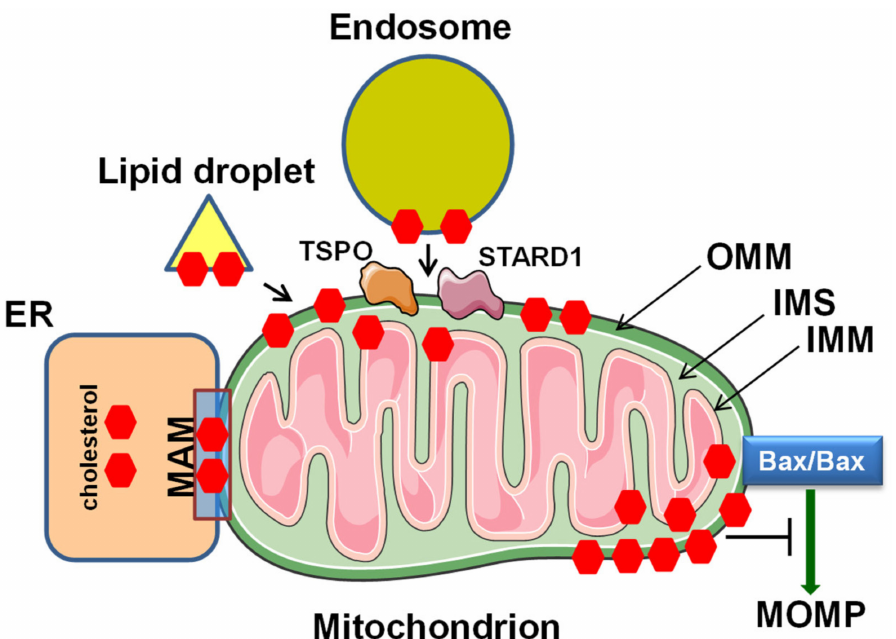
Figure 5. Import and transfer of cellular cholesterol into mitochondria. Cholesterol is transported to the mitochondria through vesicular and non-vesicular trafficking, involving the ER, lipid droplets, endosomes, TSPO and STARD1. Elevated mitochondrial cholesterol levels in cancer cells affect mito- chondrial membrane and impair Bax/Bak oligomerization in OMM and subsequent MOMP formation, representing a mechanism of cell death resistance in tumor cells. See text for details. ER, endoplasmic reticulum. IMM, inner mitochondrial membrane. IMS, inter-membrane space. MAM, mitochondria- associated membrane. OMM, outer mitochondrial membrane. STARD1, steroidogenic acute regulatory protein-related lipid transfer domain containing protein 1. TSPO, translocator